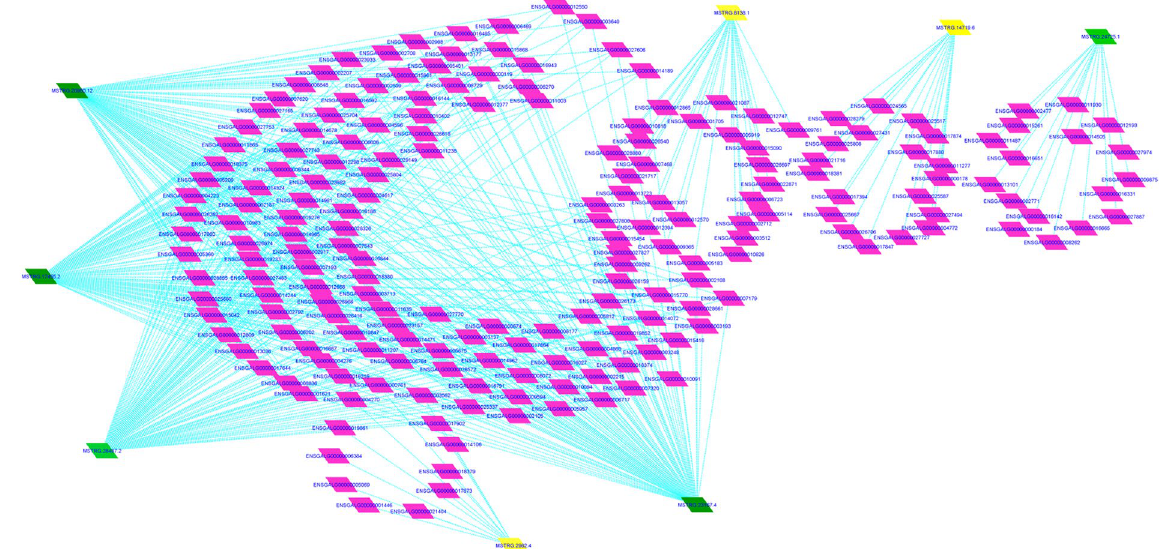
Figure 6. The regulatory network of the 8 differentially expressed lncRNAs involved in regulating the duration of fertility trait in egg-laying hens was constructed. Yellow and green nodes represent upregulated and downregulated lncRNAs in the long-DF group respectively. Pink nodes represent the predicted lncRNA target genes. Lines represent the regulatory relationships between lncRNAs and their potential target